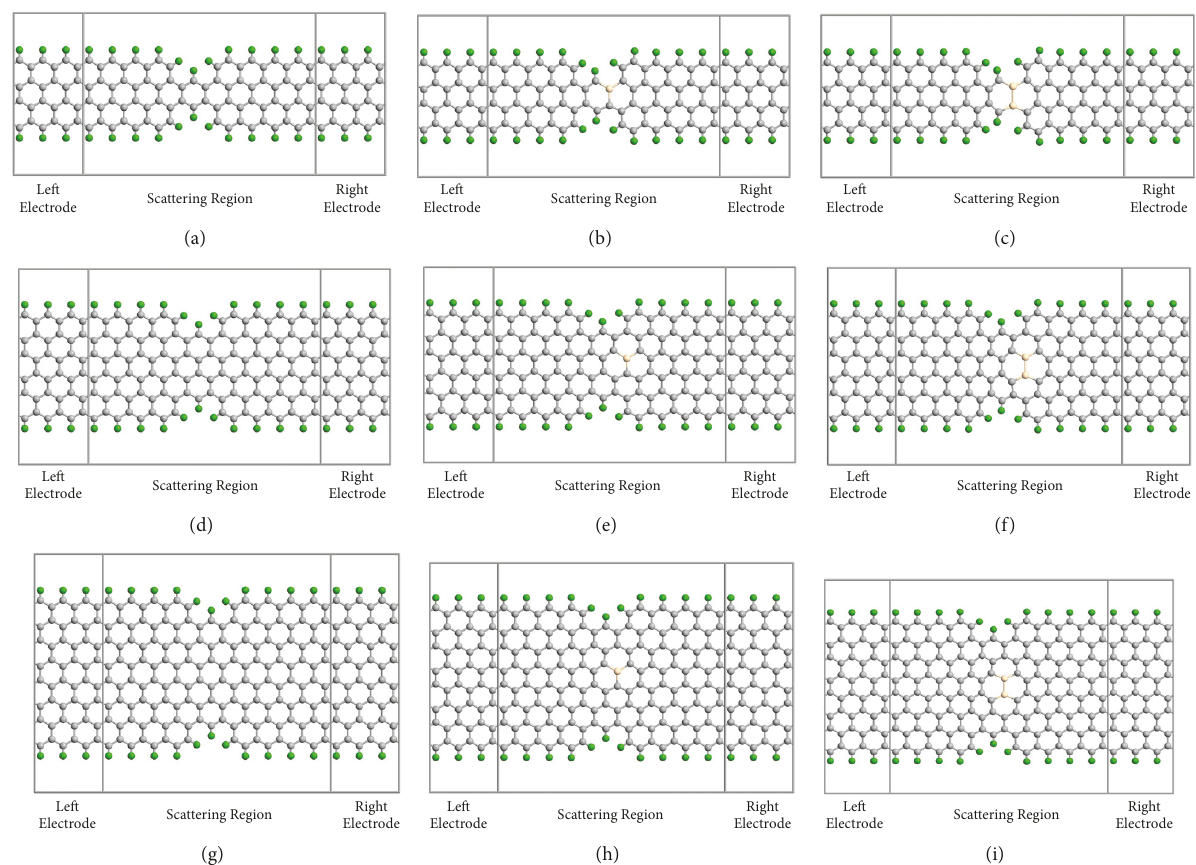
Figure 1: Schematic (top view and side view) of device geometries: (a) 4-DZGNR, (b) Si-4-DZGNR, (c) 2Si-4-DZGNR, (d) 6-DZGNR, (e) Si-6-DZGNR, (f) 2Si-6-DZGNR, (g) 8-DZGNR, (h) Si-8-DZGNR, and (i) 2Si-8-DZGNR. The hydrogen-passivated V-shaped edge DZGNRs with the single Si substitution ((b), (e), and (h)) and the double one ((c), (f), and (i)) at the center of the